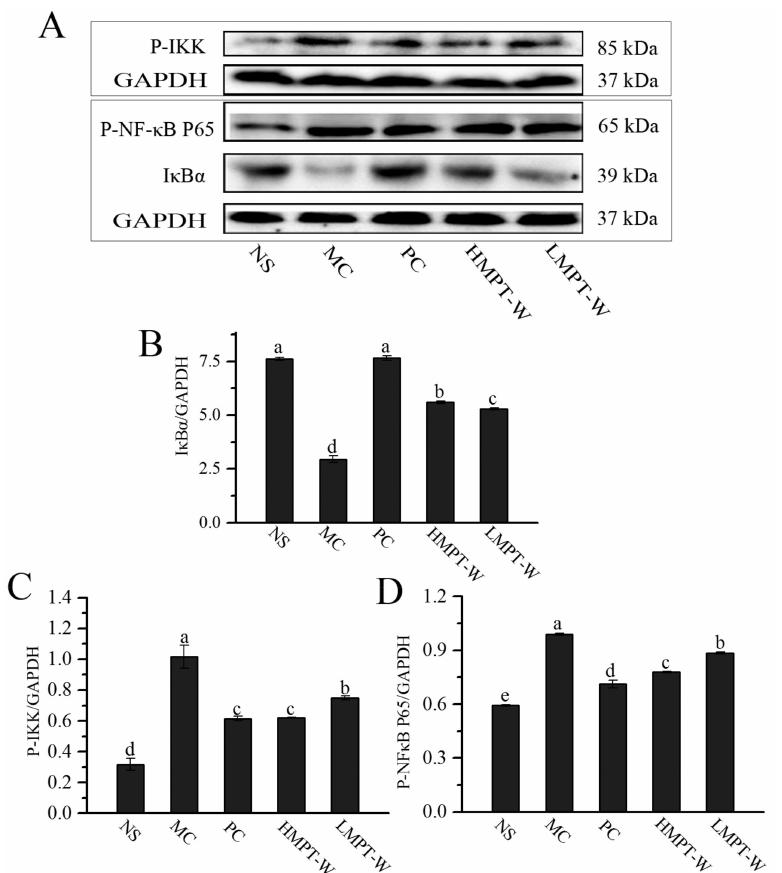
Figure 8. E ff ect of MPT-W on NF- κ B signaling pathway by immunoblotting in CCl 4 -induced chronic liver injury mice. ( A ) Western blot image; ( B ) I κ B α / GAPDH; ( C ) p-IKK / GAPDH; ( D ) p-NF- κ B p65 / GAPDH. The values are reported as means ± SD. Bars with di ff erent letters (a, b, c, d, e) are significantly di ff erent ( p < 0.05). p-NF- κ B: phospho-nuclear factor-kappa B, I κ B α : NF-kappa-B inhibitor alpha, p-IKK: phospho-inhibitor of nuclear factor kappa-B kinase, GAPDH: phosphoglyceraldehyde